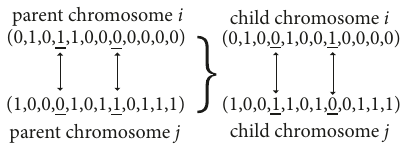
Figure 5: The crossover operator.